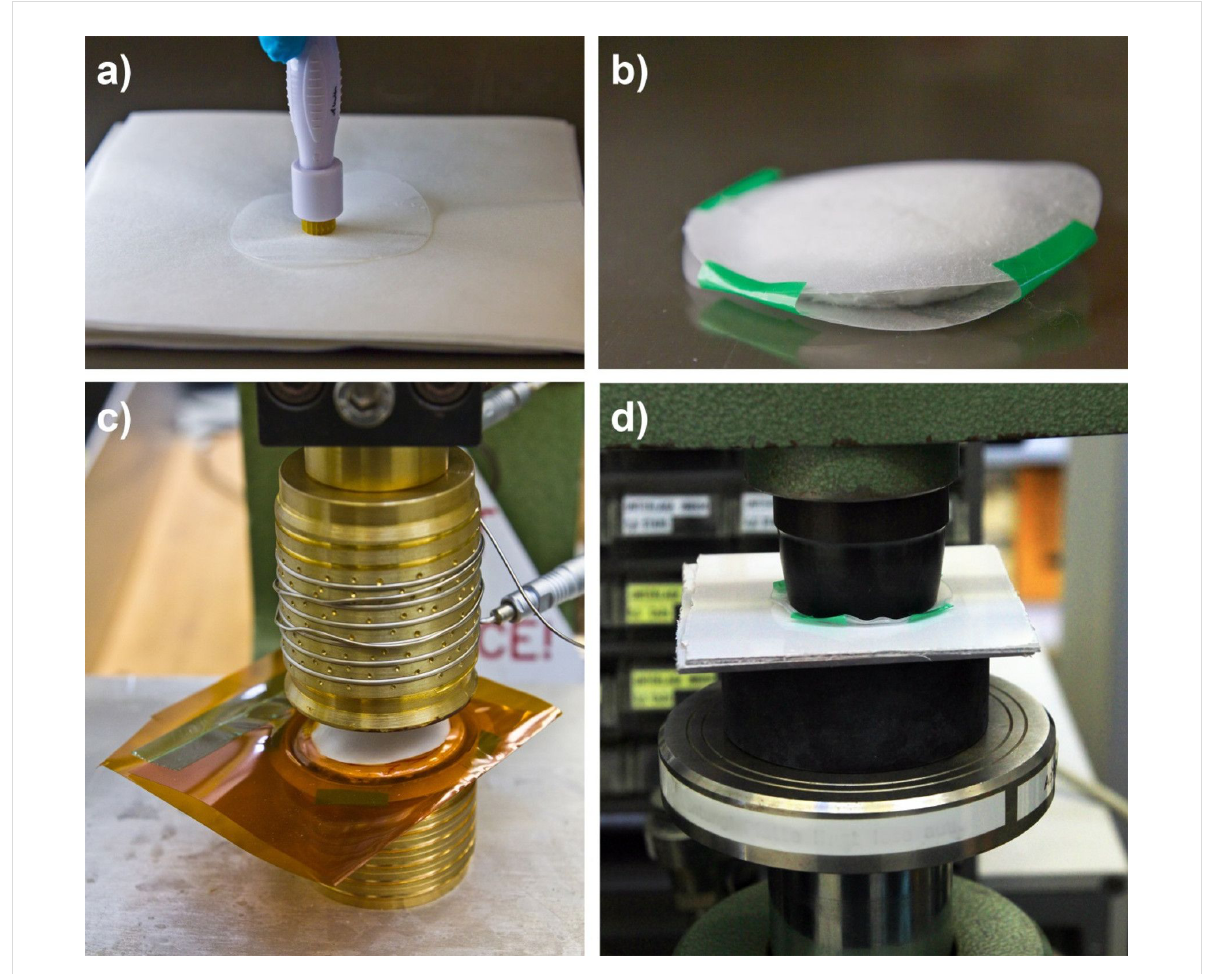
Figure 9: Fabrication of nanopads from polypropylene nanofur film. (a) In the first step, circular pieces are cut from nanofur film with a circular punch. Subsequently, tiny holes are pierced in the nanofur film using a needle pen. The needles have a diameter of about 100 µm. (b) To simplify filling the pads with oil absorbent material, the two halves are held together by scotch tape. (c) Such a preprocessed pad is placed between two polyimide films to avoid cutting through the material while welding. The upper hollow cylinder is heated and then pressed onto the pad for 15 s welding the two halves together. (d) Finally, a circular punch is applied to cut off the excess edge, leading to an evenly round pad.